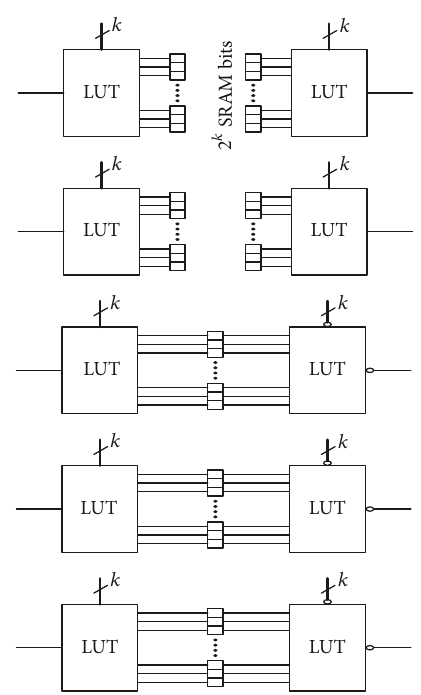
Figure 2: A CLB with 10 LUTs ( 𝑁 = 10 ) and 3 shared pairs ( 𝑃 = 3